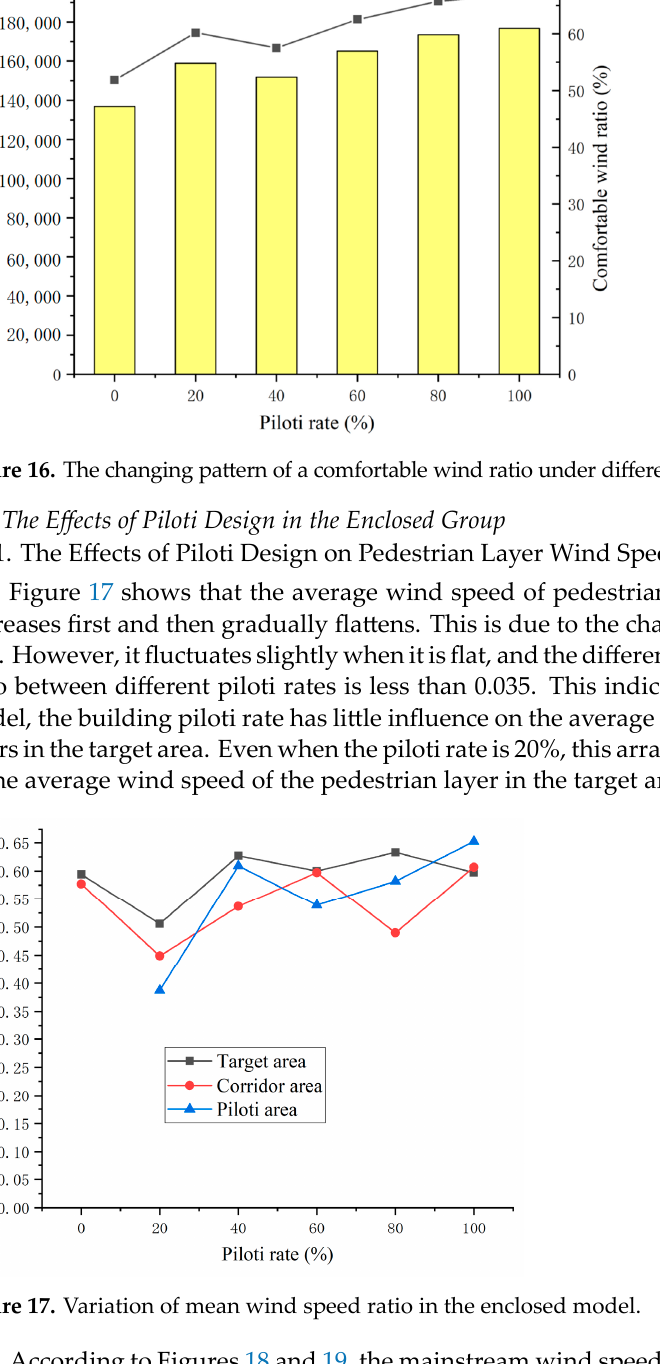
Figure 16. The changing pattern of a comfortable wind ratio under different piloti rates (Point model).